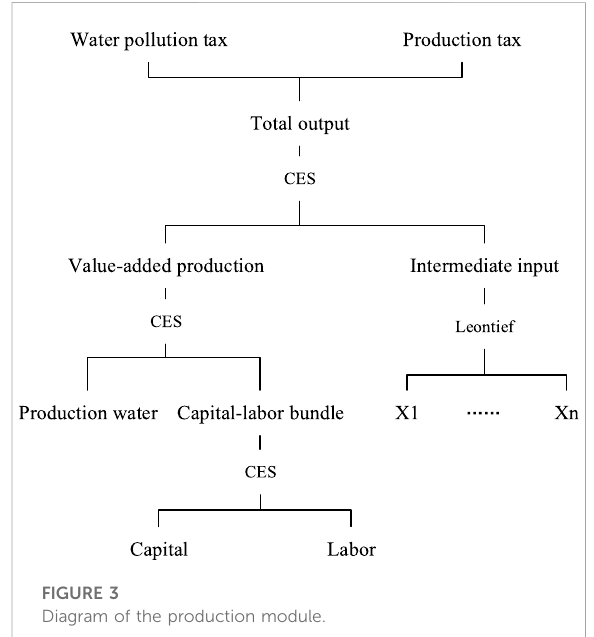
FIGURE 3 Diagram of the production